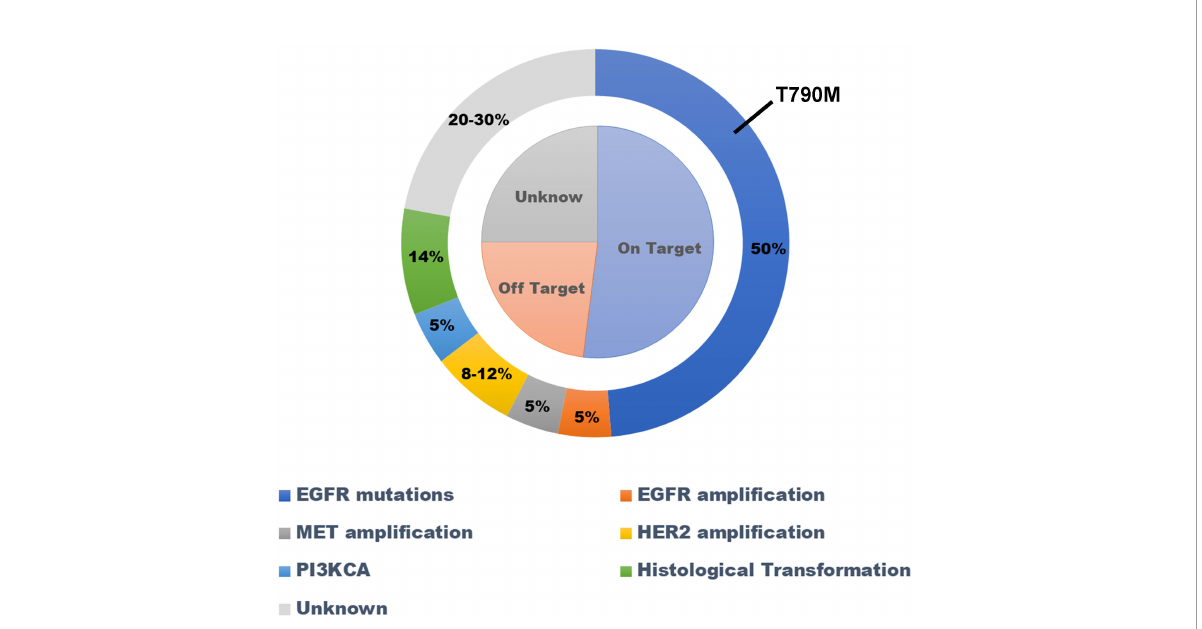
FIGURE 3 Mechanisms of drug resistance associated with using fi rst generation EGRFR-TKI as fi rst-line treatment for lung adenocarcinoma with EGFR mutation. EGFR-TKI, epidermal growth factor receptor – tyrosine kinase